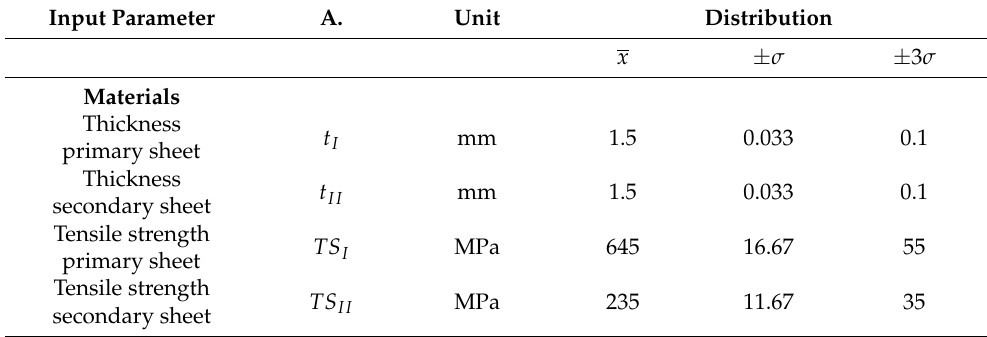
Table 2. Gaussian distributed input